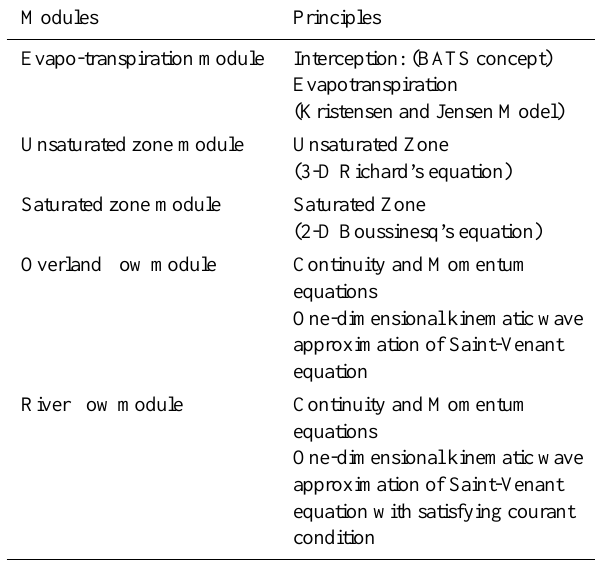
Table 1. Principles of DHM (Dutta et al.,